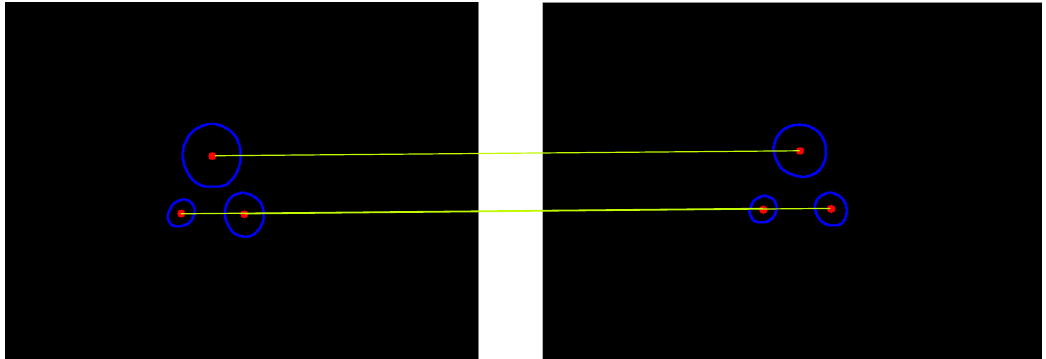
Figure 12. The matching features of the images captured by two cameras.